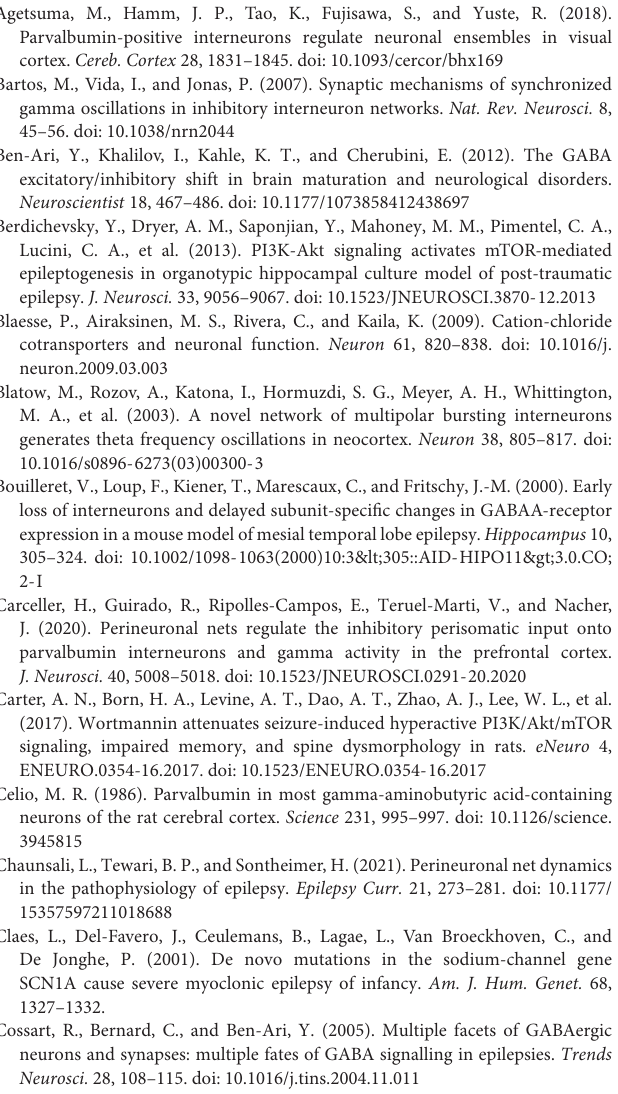
Supplementary Figure 3 | Disinhibition of cortical PV-INs upon disruption of KCC2. (A,B) Paired-pulse ratios are reduced in the motor cortex (A; n = 35/32 slices from N = 12/9 mice) and somatosensory cortex (B; n = 34/33 slices from N = 13/11 mice) of KCC2 KO PV mice (2-way ANOVA repeated measure; Bonferroni post-test; * p > 0.05; ** p < 0.001; *** p < 0.0001). (C) The frequency but not the amplitude of spontaneous inhibitory post synaptic currents (sIPSCs) is increased in the somatosensory cortex of KCC2 KO PV mice ( N = 6/6 mice; unpaired Student’s t -test; Kolmogorov-Smirnov test; ns not significant;